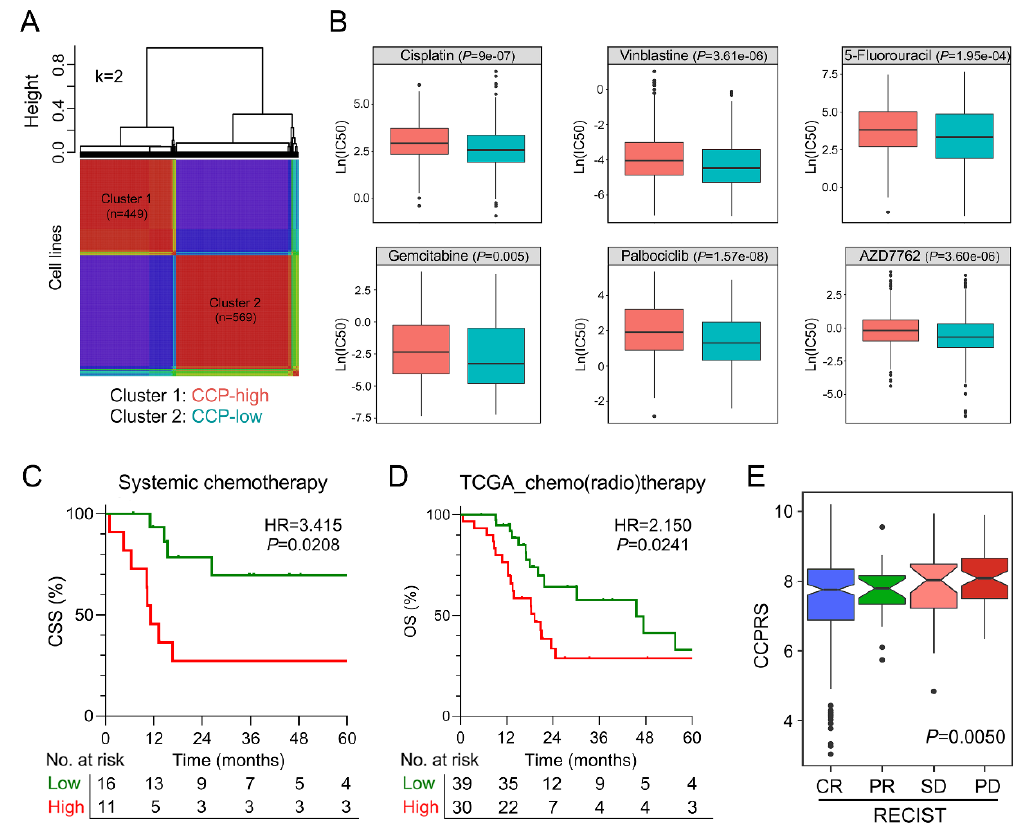
Figure 7. The gene signature serves as a promising marker for therapeutic resistance. ( A ) NMF consensus clustering was performed to divide 1018 cell lines into two clusters. ( B ) IC50 values of di ff erent routine chemotherapeutic drugs and cell cycle-targeting drugs were significantly elevated in the NMF-identified CCP-high cluster. ( C ) Among BCa patients who received systemic chemotherapy in the training cohort, those with higher CCPRS exhibited worse CSS. ( D ) Among TCGA MIBC patients who received adjuvant therapies including chemo- or / and radiotherapy, those with higher CCPRS exhibited worse overall survival. ( E ) After initial treatment, CCPRS was progressively and significantly elevated in groups with worse outcomes ( p = 0.0050).